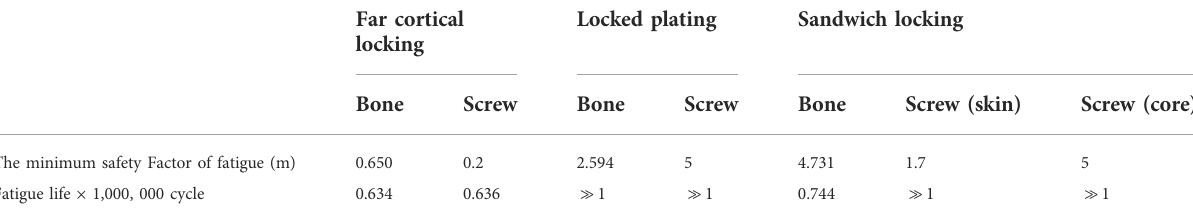
TABLE 3 Three types of structural minimum safety factors and fatigue life prediction